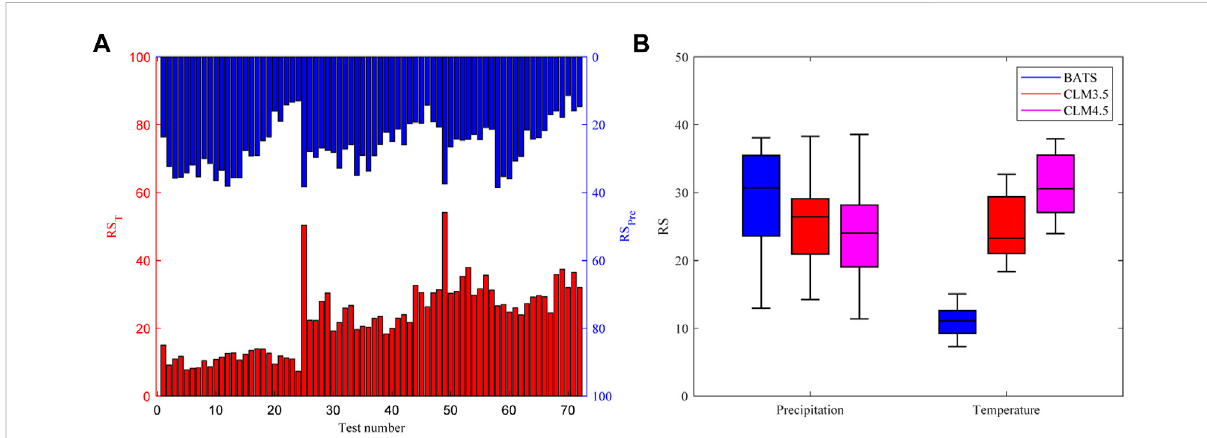
FIGURE 2 Histogram and box plot of the precipitation and temperature ranking score for the 72 sets of physical parameterization schemes. (A) Blue histogramrepresentsprecipitationscores,andredhistogramrepresentstemperaturescores; (B) Blue,redandpurpleboxesrepresentBATS,CLM3.5 and CLM4.5 scenarios, respectively.